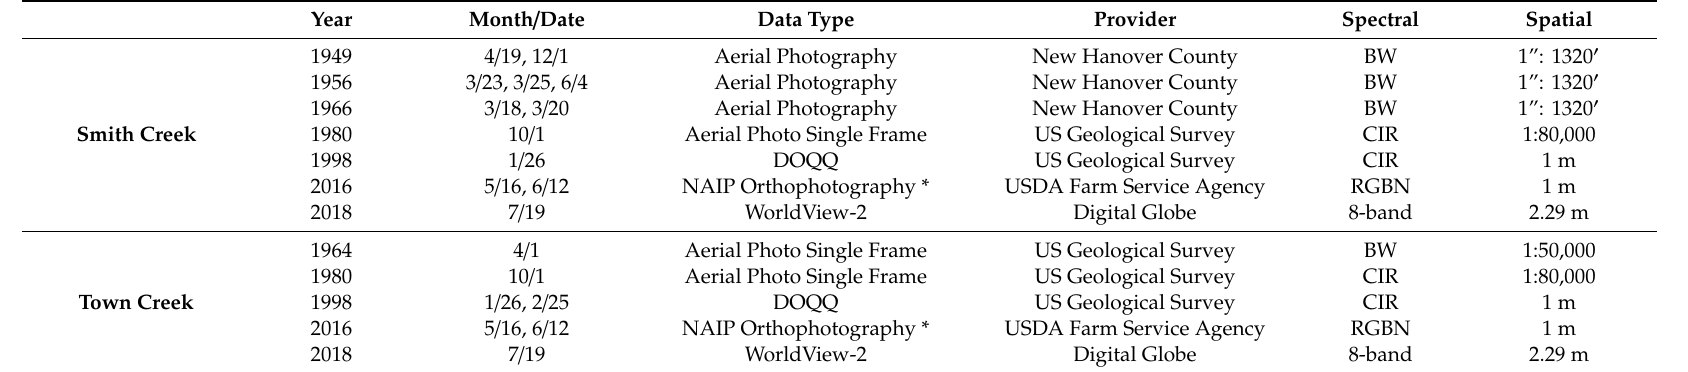
Table 1. Imagery dates, sources, spectral characteristics, and spatial scale /